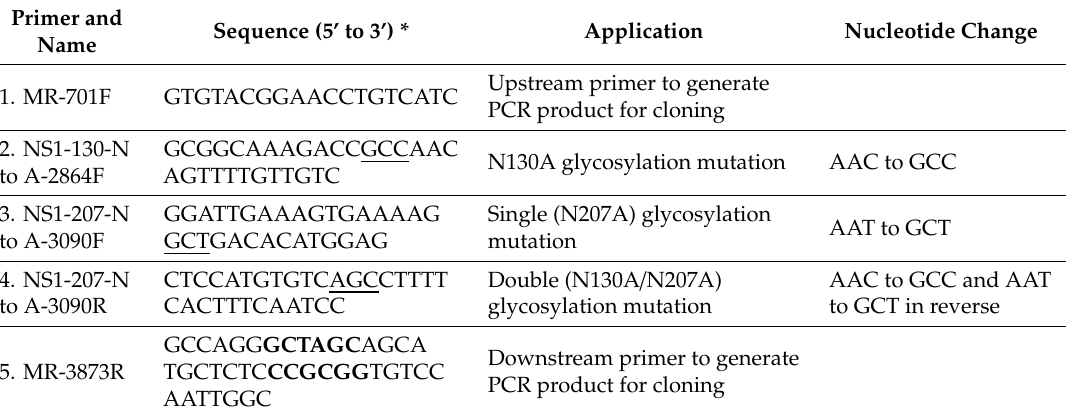
Table 1. Primers used to generate non-structural protein 1 (NS1) glycosylation site